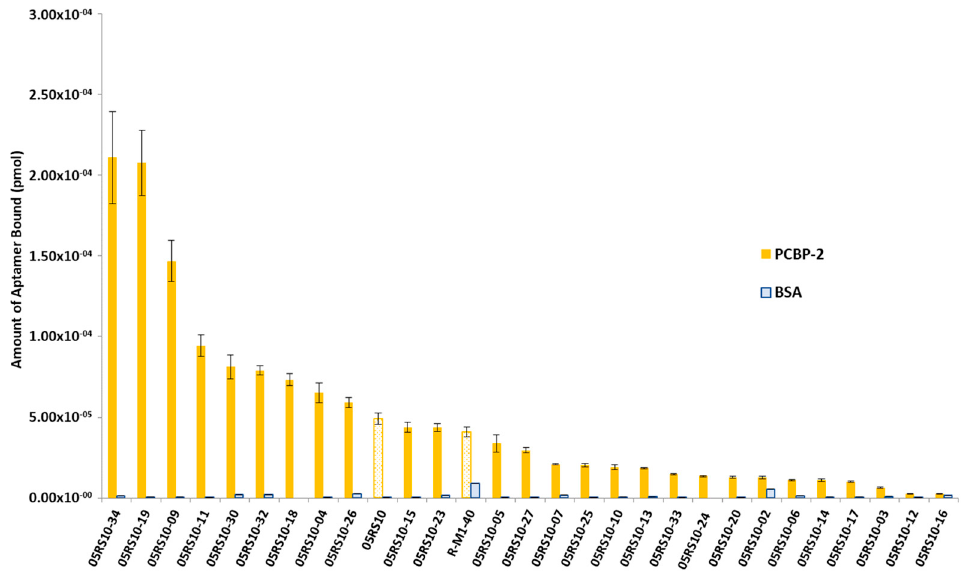
Figure 4. Screening of the PCBP-2 binding affinity of the RNA aptamers selected after 10 rounds of the SELEX process, using ELONA-RTqPCR. The Ct values obtained for each experiment (see text and Figure 3 legend for details) were interpolated using the corresponding calibration curve (Figure 2B). The mean and standard deviation (not visible for the BSA data) values of three independent experiments are shown. The whole aptamer population present at the final SELEX round (05RS10) and the random population used as the starting material for the selection process (R-M1-40) were assayed in parallel.